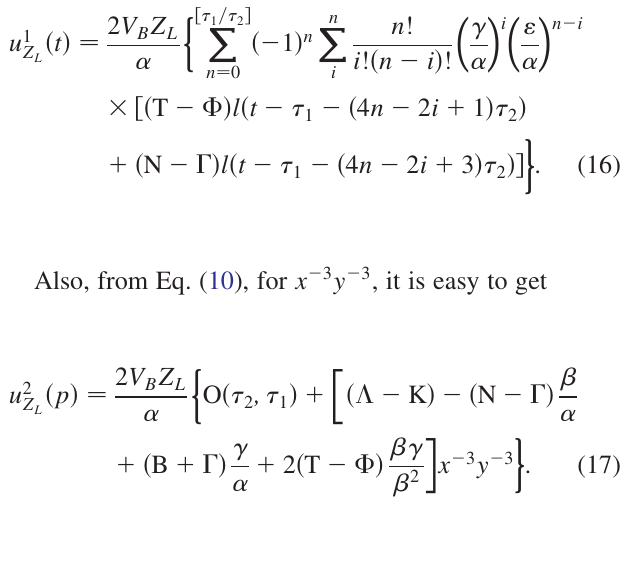
¼ Z ¼ 6 (cid:6) , Z ¼ 8 (cid:6) ; (c) Z 1 3 L